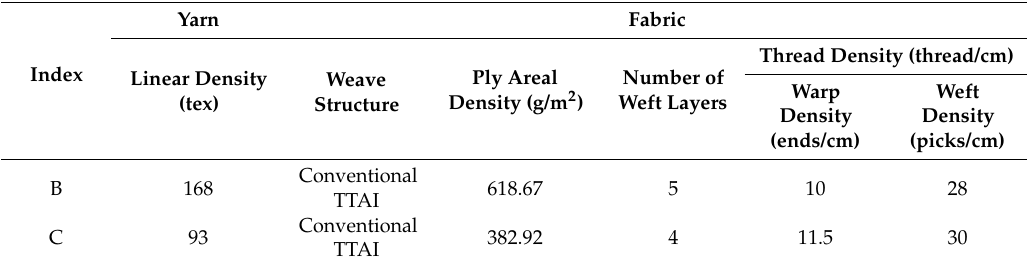
Table 1. Weave specifications of the composite